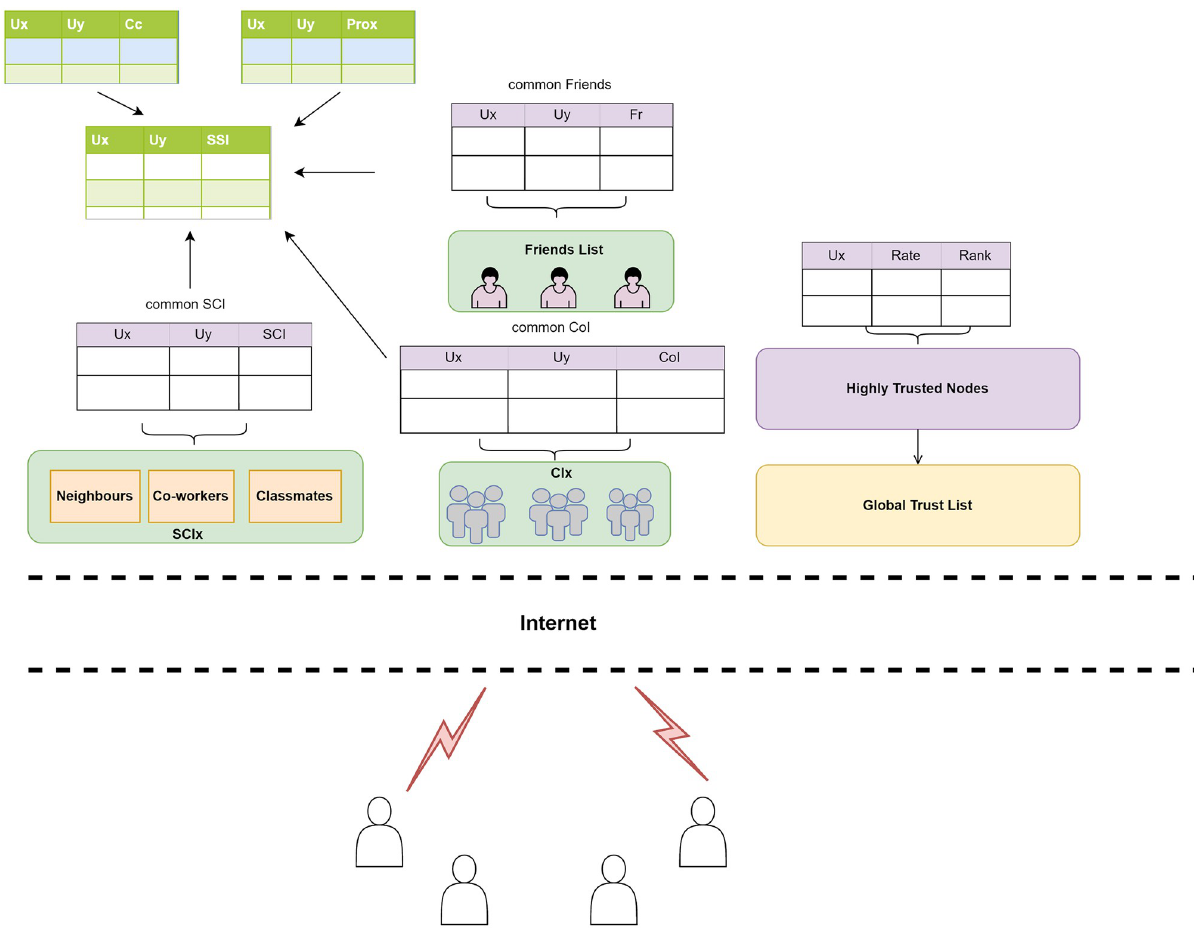
Fig 4. Cloud-based trust computing